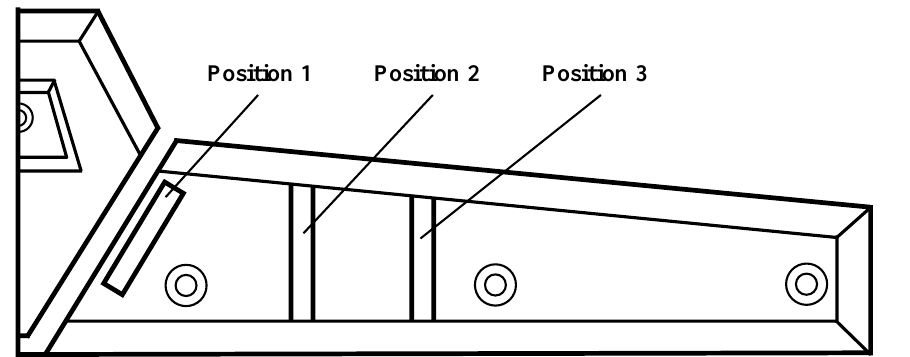
Figure 3. Position of gas curtain.